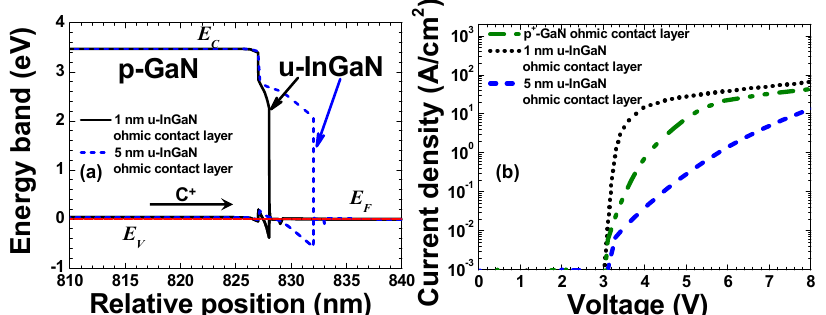
Figure 2. ( a ) Energy band diagrams at the equilibrium state for u-InGaN/p-GaN structures with the u-InGaN layer thicknesses of 1 nm and 5 nm, respectively; ( b ) calculated current in terms of the applied voltage for LEDs with p + -GaN, 1 nm thick u-InGaN and 5 nm thick u-InGaN as the ohmic contact layers, respectively. Here, u-InGaN, E C , E V ad E F represent the undoped InGaN cap layer, the conduction band, the valence band and the Fermi level, respectively.